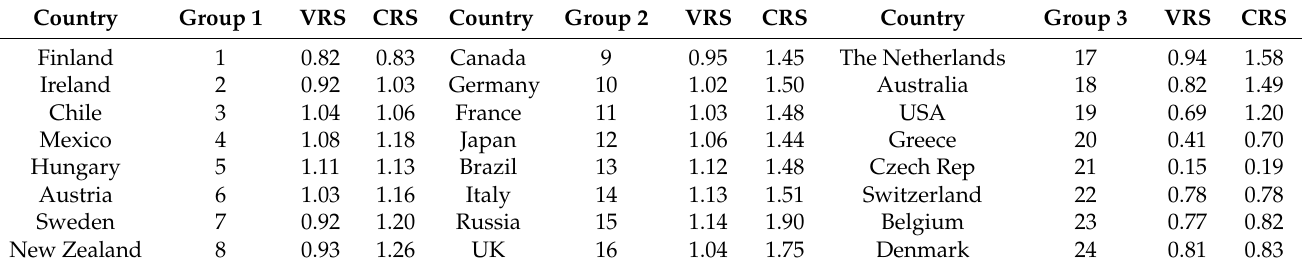
Table 5. Interconnections of OECD destination countries for Chinese outward FDI using Tabu search.